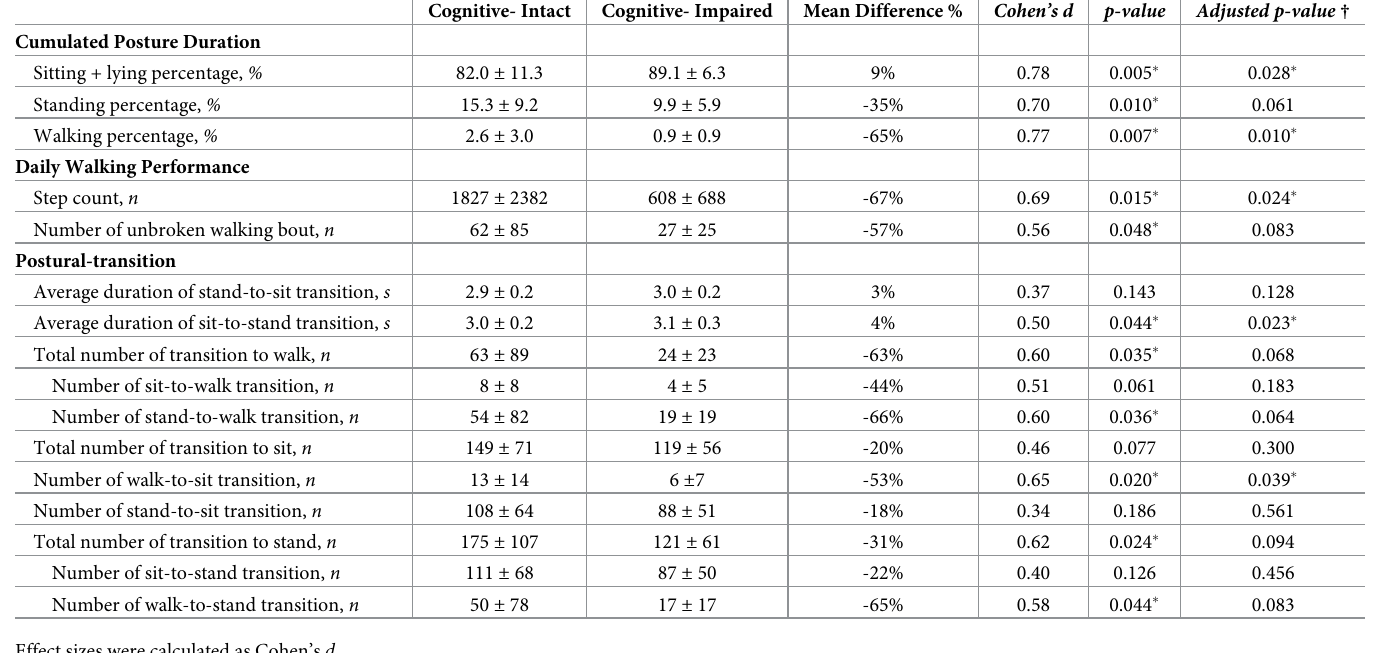
Table 2. Mobility performance (in 24-hour) comparison for cognitive-intact and cognitive-impaired groups.